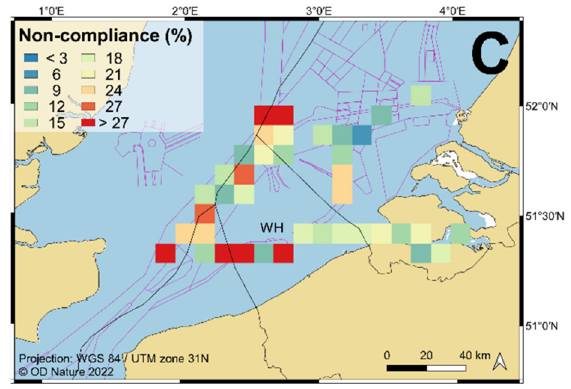
Figure 9. Non-compliance grid map with a grid size of 5 km, for the period of 2020–2021 ( A ), for 2019 applying the lowered thresholds ( B ) and for the 2019 data applying the bias and the lowered threshold ( C ). A filter of a minimum of ten OGVs per grid cell was used for assessing compliance levels.